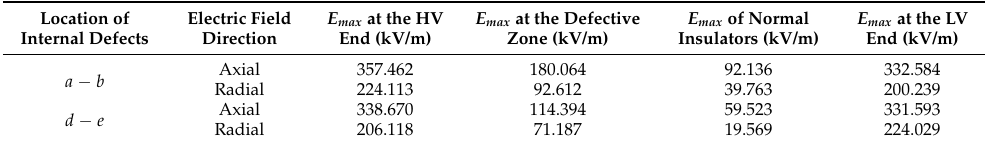
Table 4. Calculation results of the electric field in the axial direction for the composite insulator with internal